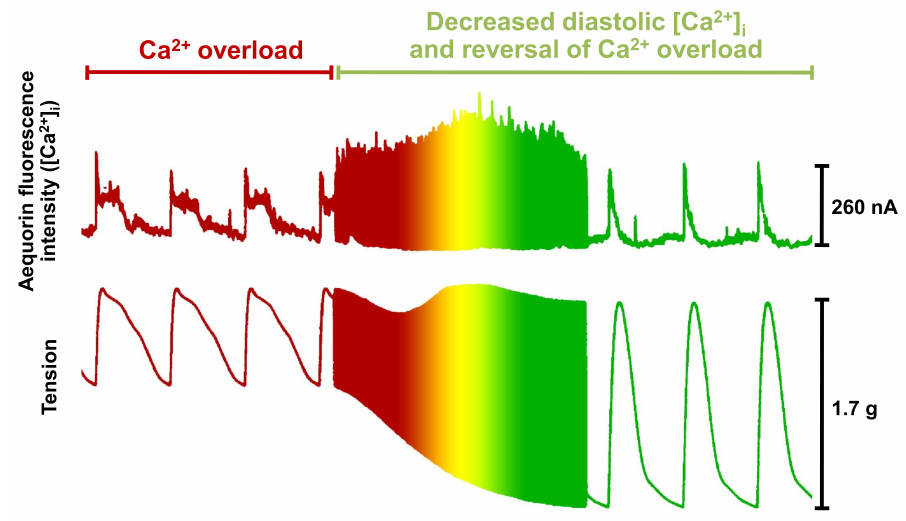
Figure 4. The impact of calcium overload on systolic and diastolic function. In trabeculae from a patient with heart failure, there was a slowed contractile response as well as slowed reuptake of Ca 2+ by the SR and delayed return to normal diastolic Ca 2+ levels. When diastolic Ca 2+ concentration was reduced and restored to pre-Ca 2+ loading concentrations, there was first an overshoot in the Ca 2+ transient amplitude showing increased SR Ca 2+ re-uptake, which was followed by a normalization of amplitude and time course of the Ca 2+ transient. Associated with these changes in Ca 2+ transient amplitude and time course and a decrease in diastolic Ca 2+ concentration, there was a tremendous increase in contractile force. This figure demonstrates the negative impact of elevated diastolic Ca 2+ on not only diastolic force and muscle relaxation, but systolic force as